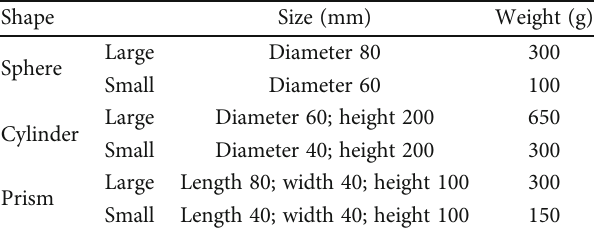
Table 2: Shape, size, and weight of the six grasping